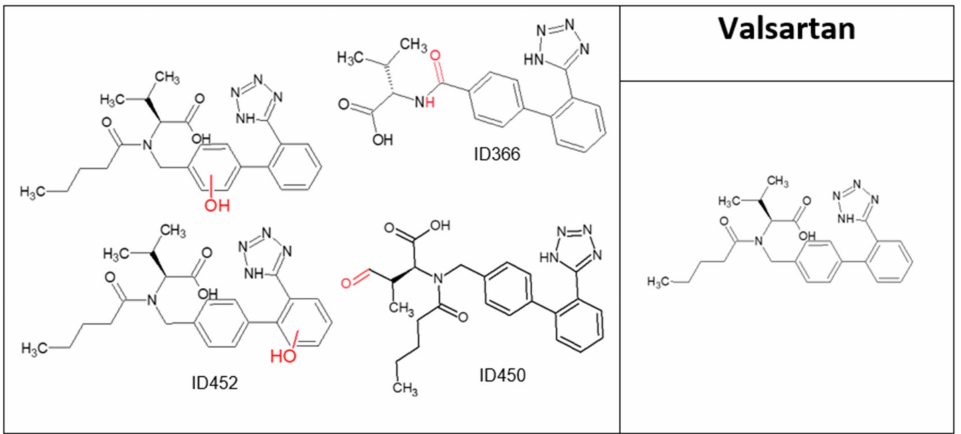
Figure 6. Valsartan and its major transformation products. Table 6. Valsartan transformation products’ identification